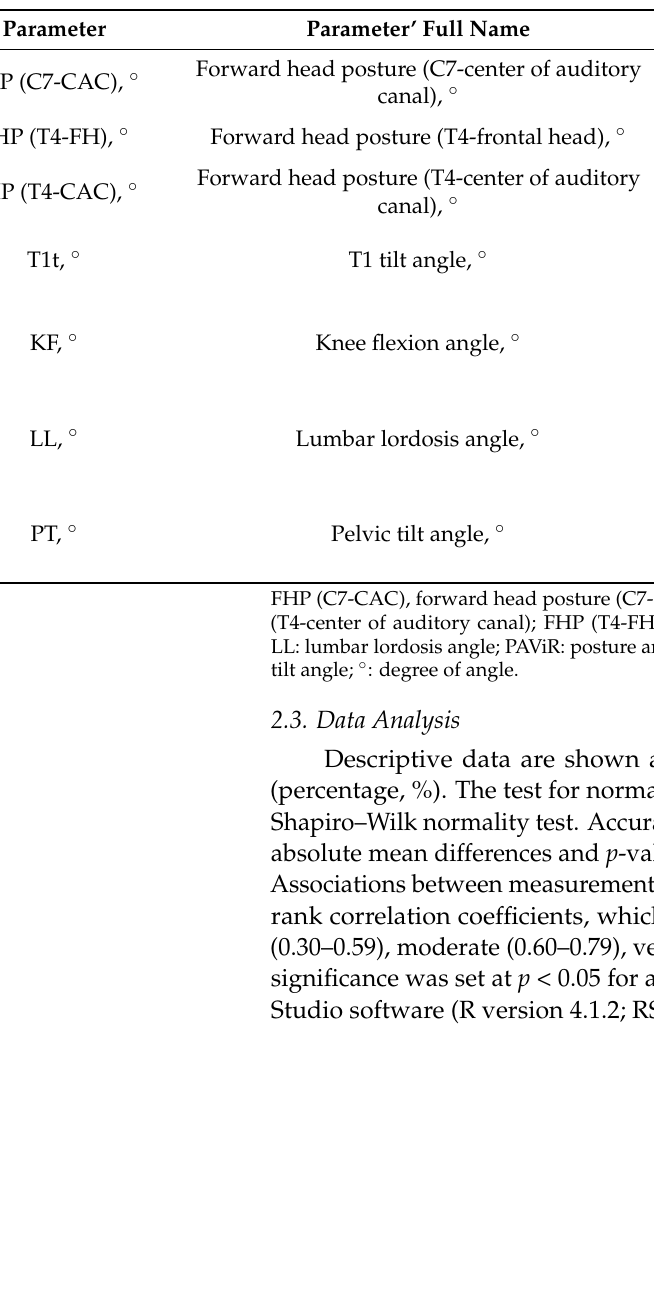
Table 1. Description of the sagittal parameters of